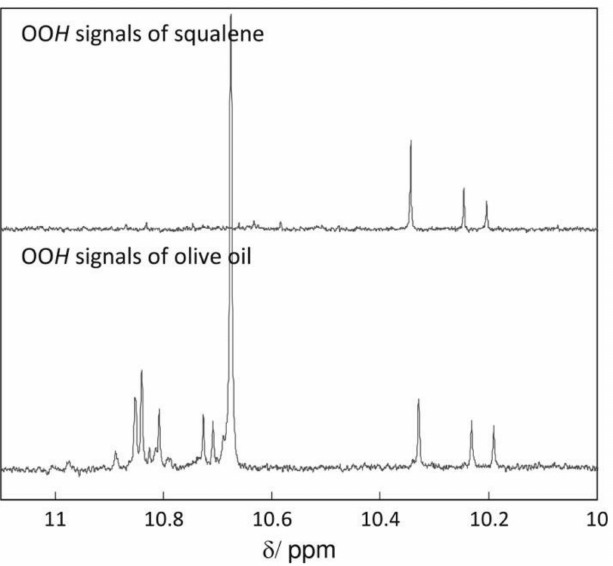
Figure 30. Hydroperoxide-proton region of olive oil compared to that of oxidized squalene. Reprinted with permission from [130]. Copyright 2012, AOCS.